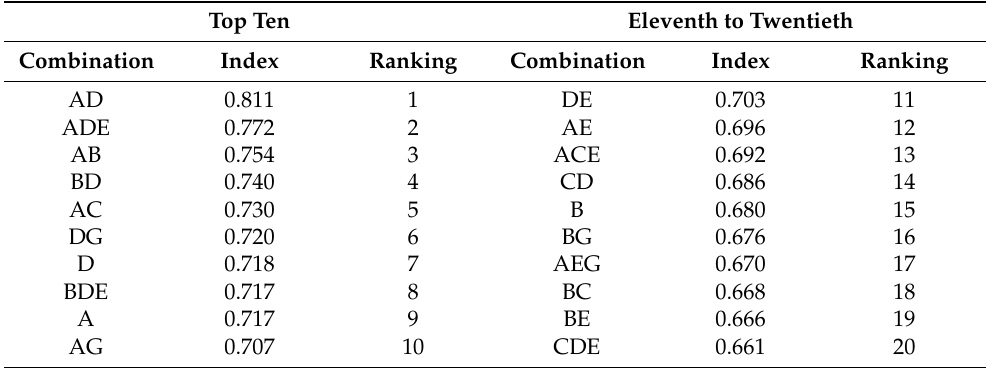
Table 2. The decision-making indexes of countermeasure combinations (top twenty).